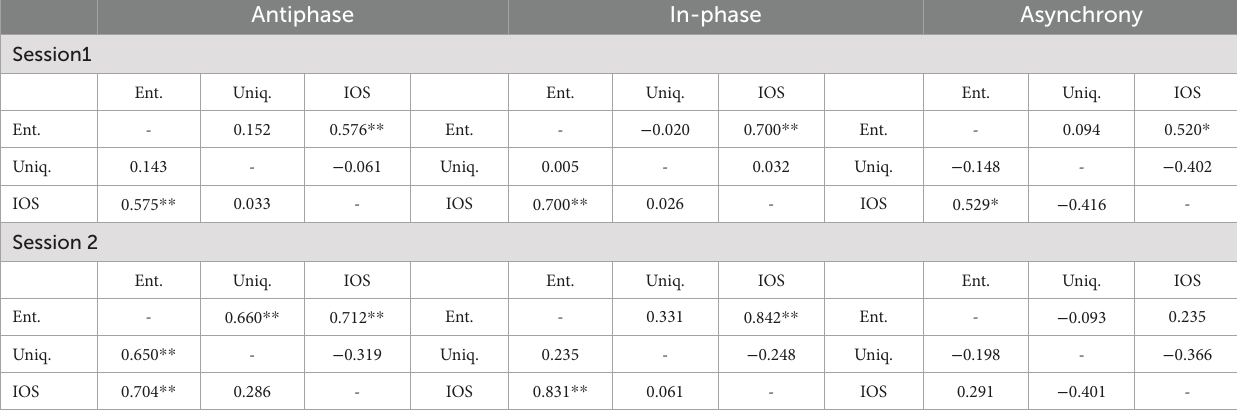
TABLE 3 Correlations and partial correlations between entitativity, uniqueness, and IOS (self-other